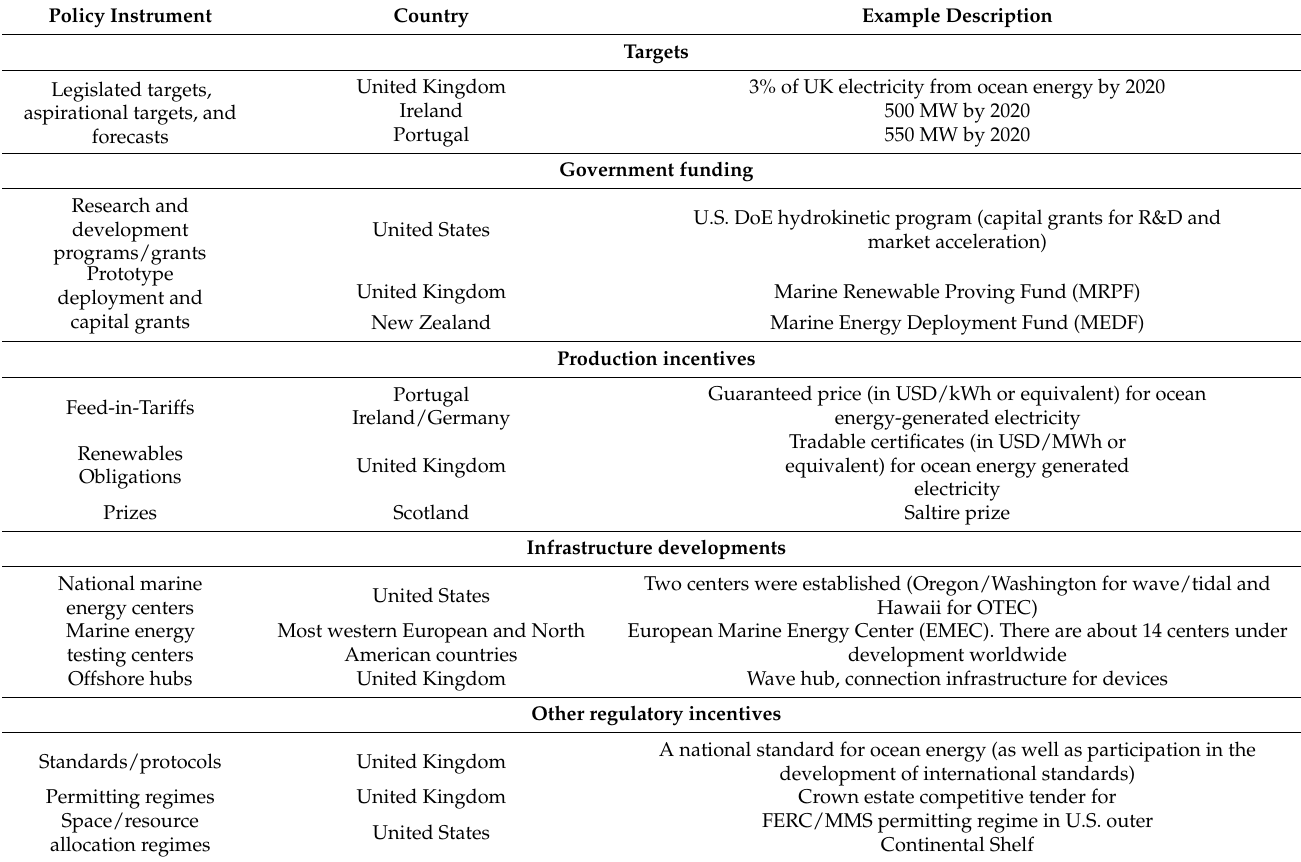
Table 12. Governmental policy instruments for ocean